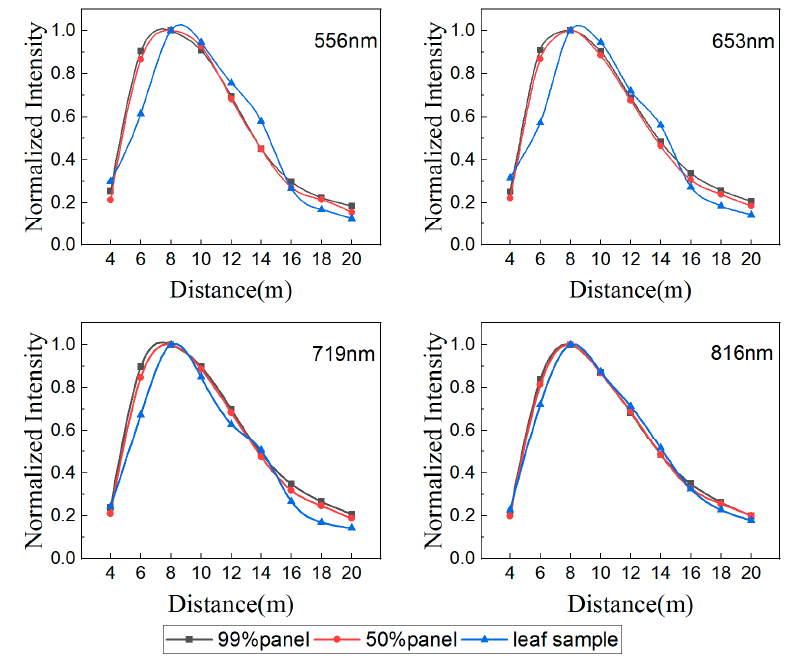
Figure 9. Backscattered intensities of the four laser wavelengths for the standard panels and leaf sample are normalized to 1 at 8 m.